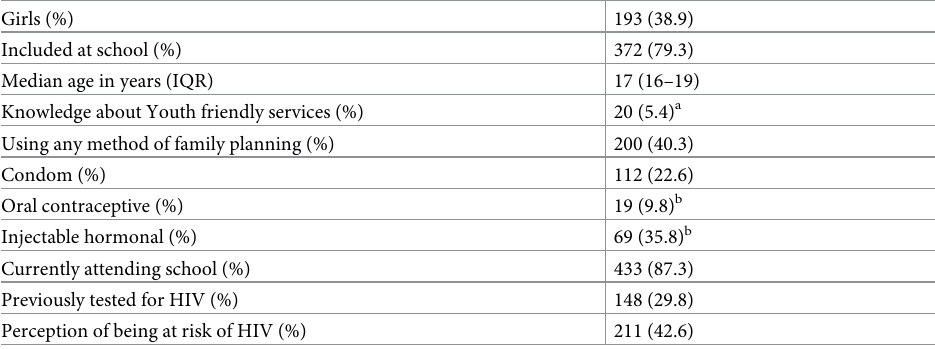
Table 1. Baseline characteristic of the study participant (n =